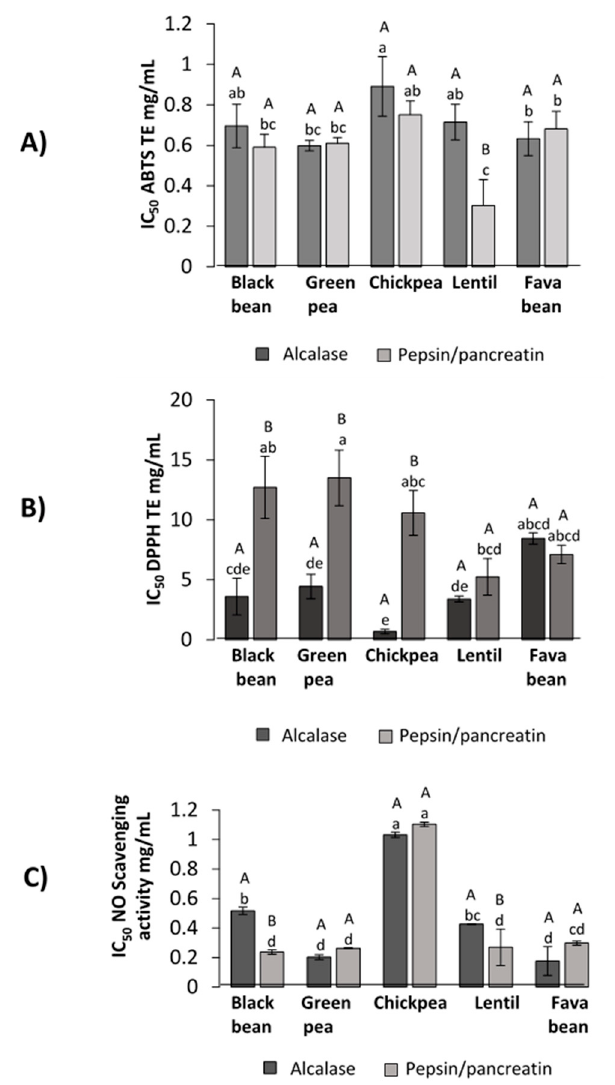
Figure 3. Antioxidant potential of LPH against di ff erent radicals. ( A ) ABTS scavenging activity (IC 50 TE mg / mL), ( B ) DPPH scavenging activity (IC 50 TE mg / mL), ( C ) nitric oxide scavenging activity (IC 50 mg / mL). Di ff erent capital letters indicate significant di ff erences between alcalase and pepsin / pancreatin digestion ( p < 0.05); di ff erent lowercase letters indicate significant di ff erences ( p < 0.05) among legume protein hydrolysates. Results represent the mean ± SD of at least two independent experiments.